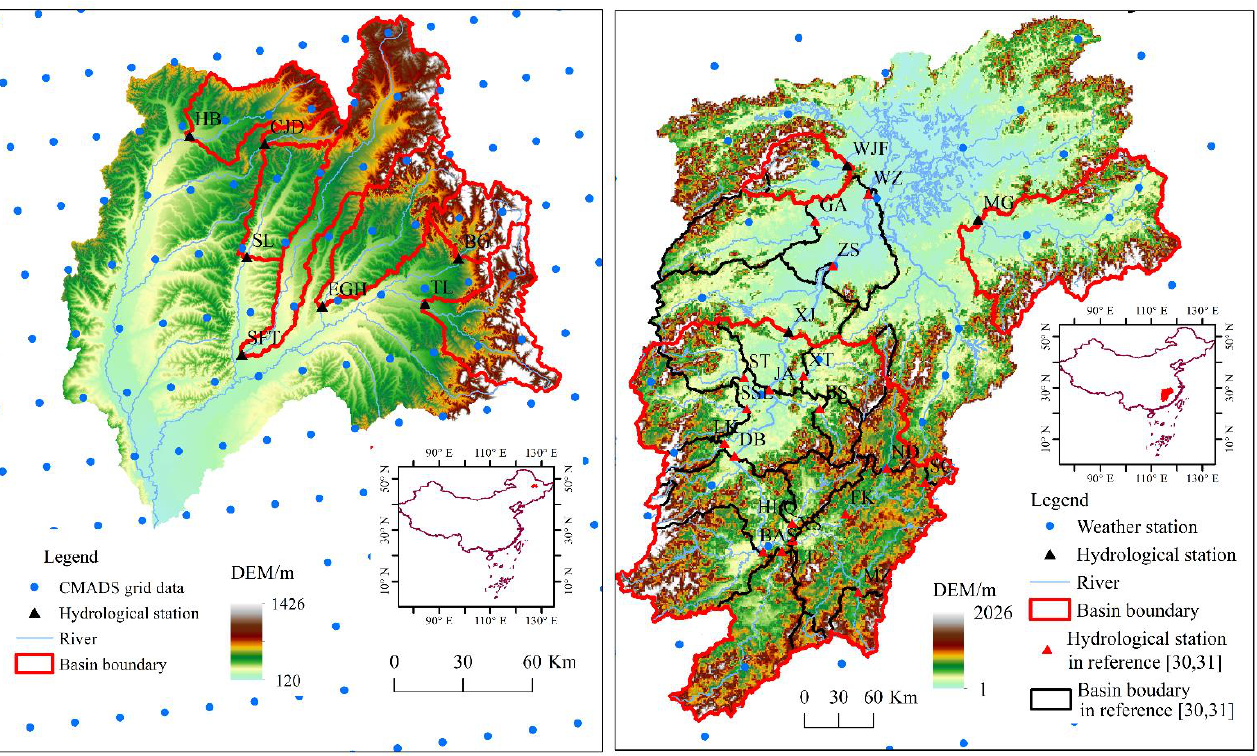
Figure 1. Distribution of hydrological stations and meteorological stations in the Hulan River Basin, central Heilongjiang Province, China and the Poyang Lake Basin, northern Jiangxi Province, China. Table 1. Information on the Hulan River Basin and Poyang Lake Basin and their hydrological station.